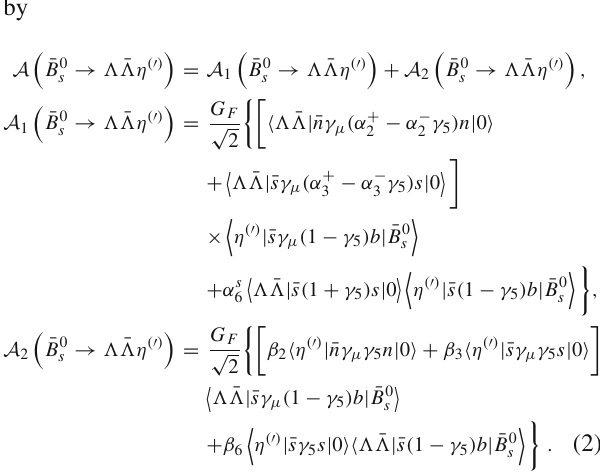
¯ → (cid:3) ¯ (cid:3)η ( (cid:3) ) are given B 0 s